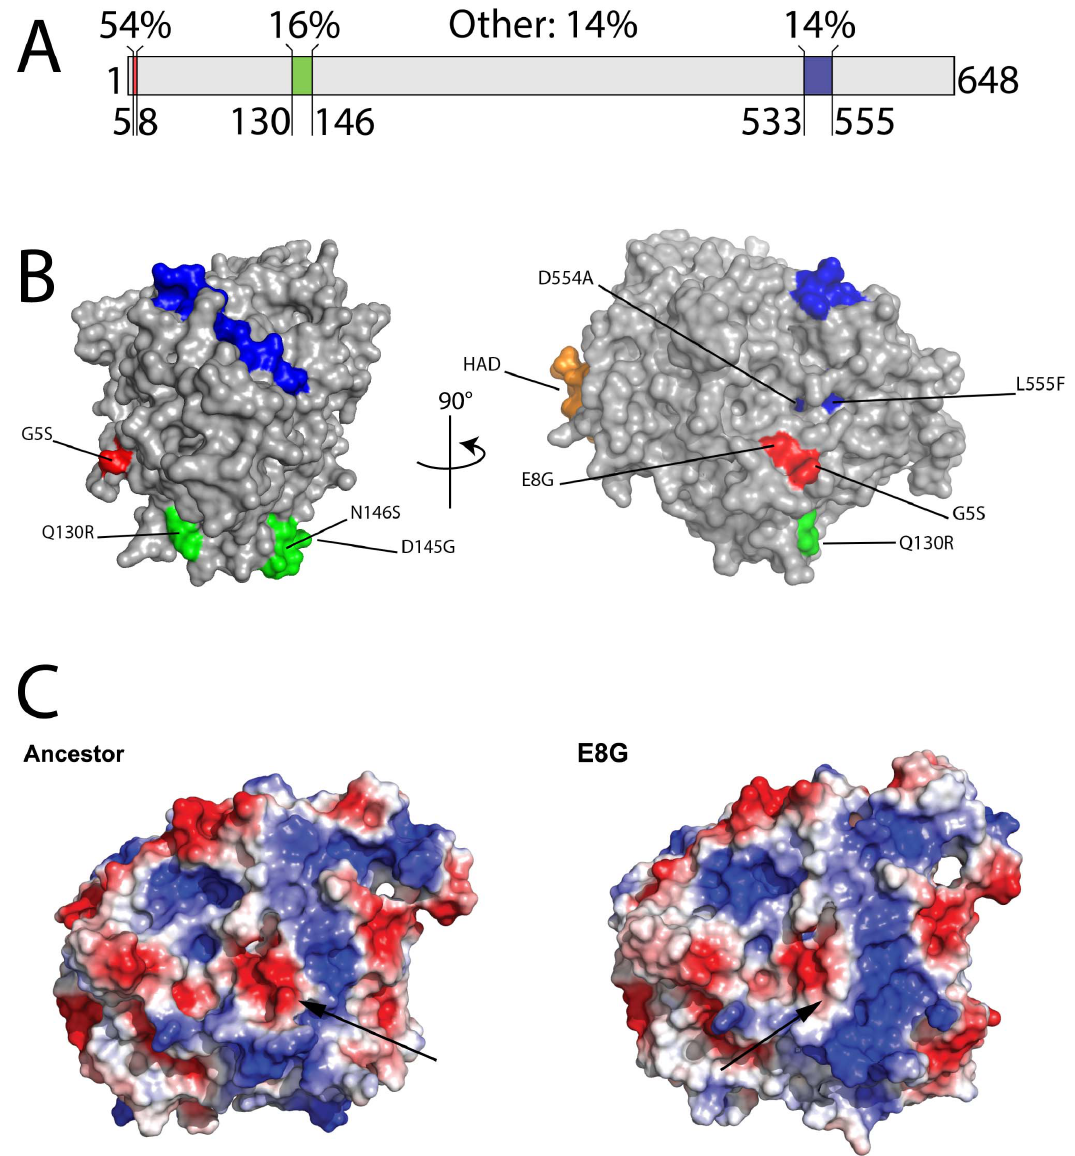
Figure 1. Spatial models of 6 P3 protein mutants. Panel A: Three host range mutation hotspots (accounting for 86% of all mutations) are highlighted in this linear representation of the 648 amino acid sequence of the 6 P3 gene. The remaining 14% of mutations are not shown. Panel B: Space-filling representations of the 6 P3 protein are shown as predicted by I-TASSER. Colored regions correspond to the mutation hotspots depicted in Panel A. A putative hydrophobic anchoring domain (HAD) is shown in orange. In our model, the hydrophobic anchoring domain penetrates 6’s outer lipid membrane to bind inner membrane protein P6. Panel C: Surface electrical charges of E8G mutant contrasted with ancestor. Space-filling representations showing predicted surface electrical charges for the 6 E8G host range mutant and its ancestor were estimated using I-TASSER. Positively- and negatively-charged regions are depicted in blue and red respectively. Arrows indicate the predicted location of the mutated 8 th residue. The most prominent difference between the mutant and the ancestor is the greater surface positive charge at the presumed host binding domain.